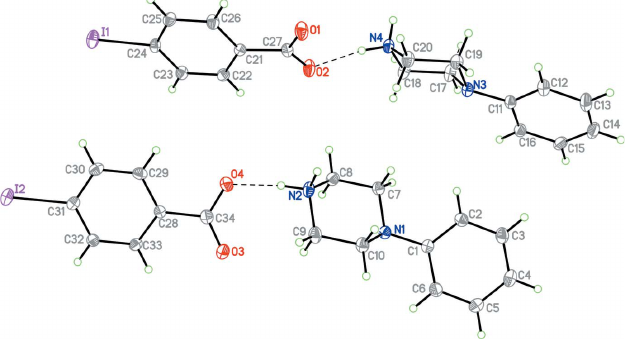
Figure 3 The molecular structure of 4 with hydrogen bonds shown as dashed lines. Atomic displacement parameters are at the 30% probability level.